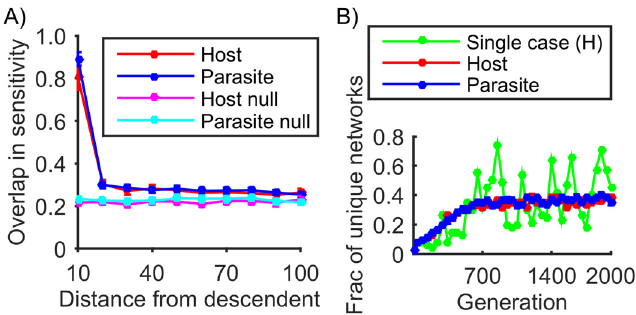
Fig 3. Lability of sensitive interactions and network diversity. A) Comparison of the sensitivity network interactions from a single individual in a population at generation 2000 with its ancestors using the Jaccard index to quantify the overlap in sensitivity (see Methods). (B) Time course of network diversity, defined as the number of distinct networks, simplified to sign (-1/0/+1) form, and expressed as a fraction of the population (green line: host population of single simulation). Apart from the green line in (B), both plots show mean values for 100 simulations with the error bars indicating SEM.